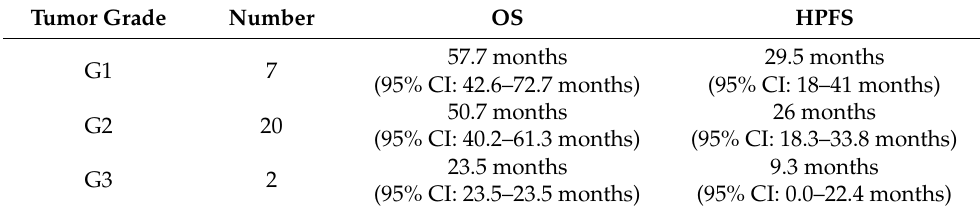
Table 2. OS and HPFS according to histopathological grading of